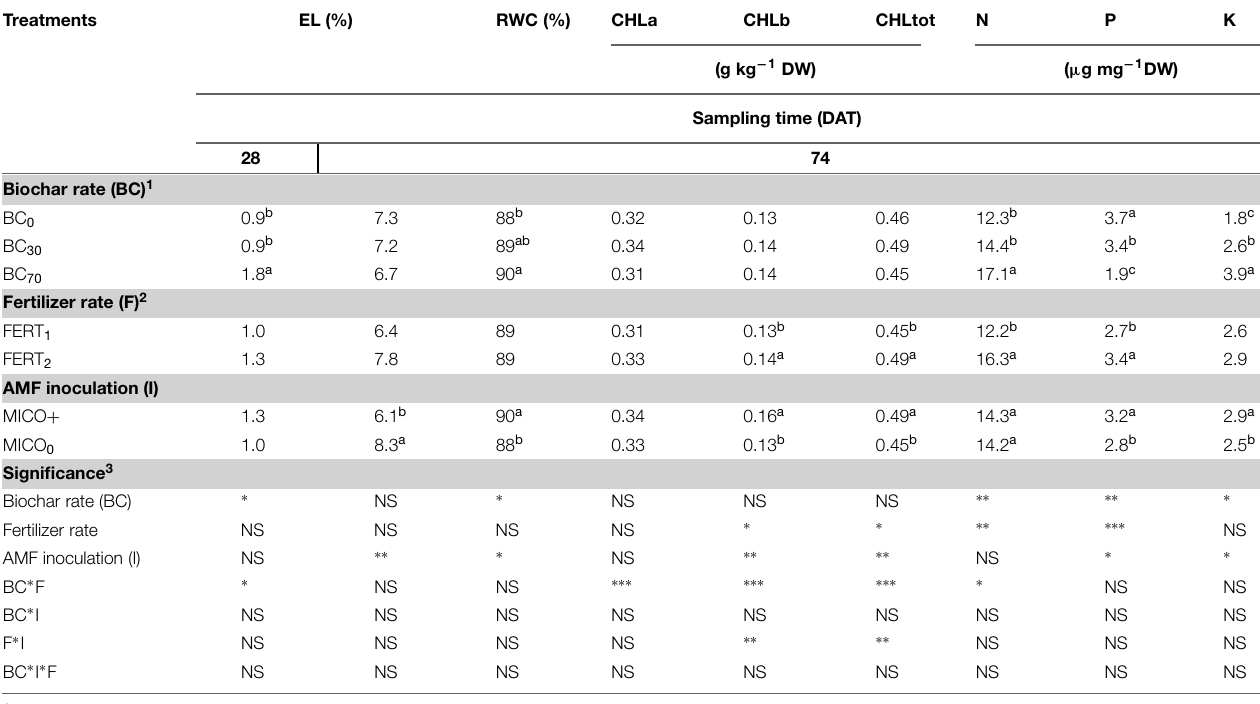
TABLE 5 | Physiological indices, nitrogen (N), phosphorus (P), potassium (K), and chlorophyll (CHL) concentrations of Pelargonium leaves in plants inoculated (MICO + ) or not (MICO 0 ) with arbuscular mycorrhizal fungi (AMF) and grown for 28 (only electrolyte leakage) and 74 d in substrate amended with different rates of biochar (BC 0 , BC 30 , BC 70 ), and fertilized with different rates of fertilizer (FERT 1 , FERT 2 ). Treatments EL (%) RWC (%) CHLa